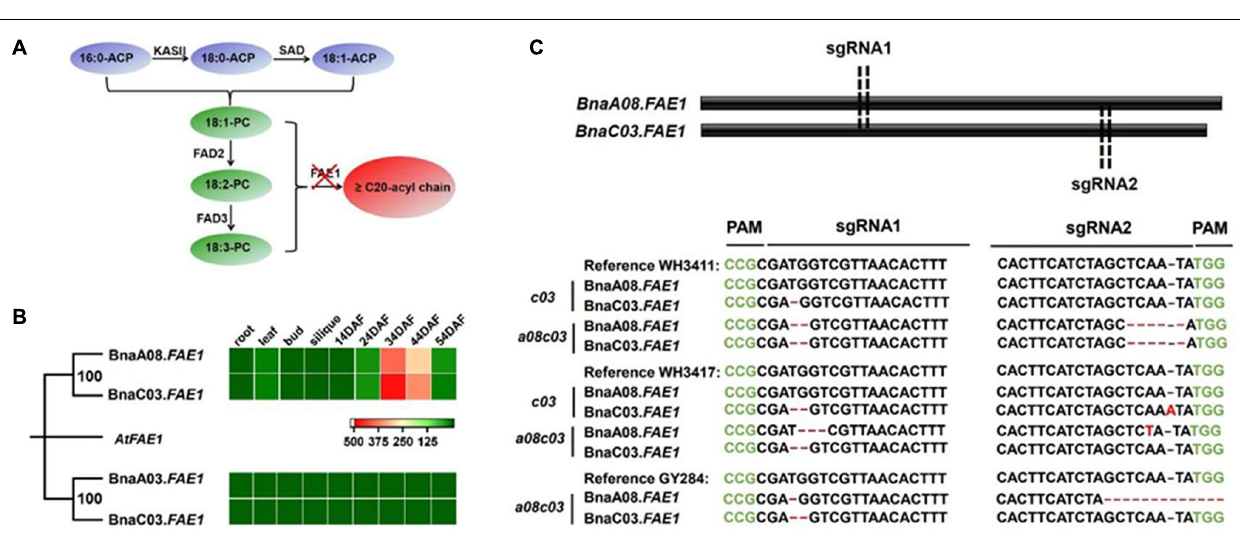
Frontiers in Plant Science |